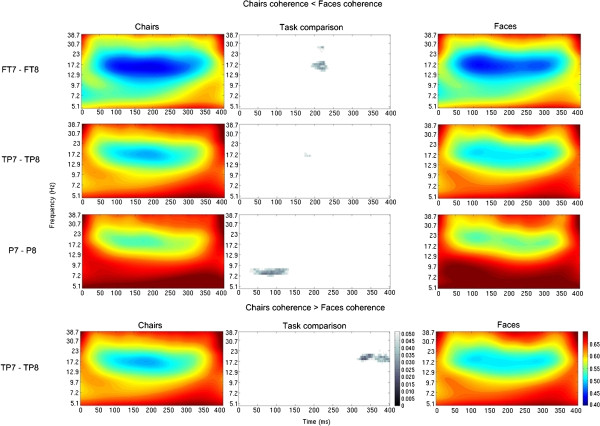
Mann–Whitney task comparison of interhemispheric coherence for the control group (uncorrected P-values). The colored graphs represent values of wavelet coherence for the control group, for every time-frequency point and for each task (Chairs: left column, Faces: right column), for different electrode pairs (each row) and directions (decreased coherence for chairs task relative to faces task on first three rows, increased coherence for chairs relative to faces task on last row); areas in blue represent regions of low coherence in the time-frequency spectrum, while areas in red represent regions of high coherence. The graphs in the middle column represents the statistical task comparison for different electrode pairs; areas shaded gray represent regions of the time-frequency spectrum where there is a significant difference in coherence between the chairs and the faces task, at P (uncorrected) <0.05. For the control group, no areas of significant differences in coherence between tasks were found for any other electrode pairs.